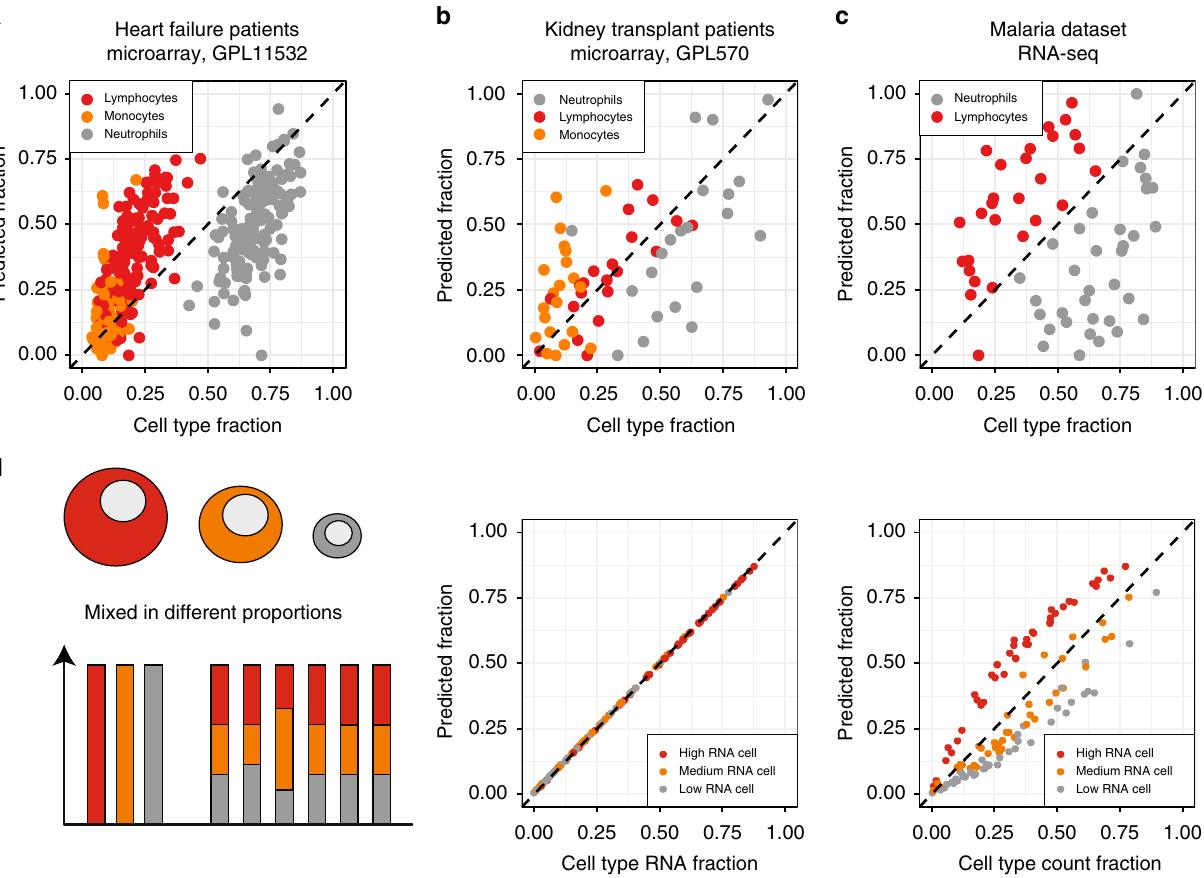
Fig. 7 Complete deconvolution pipeline reveals bias when fractions are compared to blood counts. The results of the pipeline for dataset GSE20300 ( a ), GSE77434 ( b ), and E-MTAB-6413 ( c ). d Simulation dataset where cell types had different RNA content. In the middle, predicted proportions are compared against fraction of cell types RNA in the sample. On the right, predicted proportions are compares against actual cell type